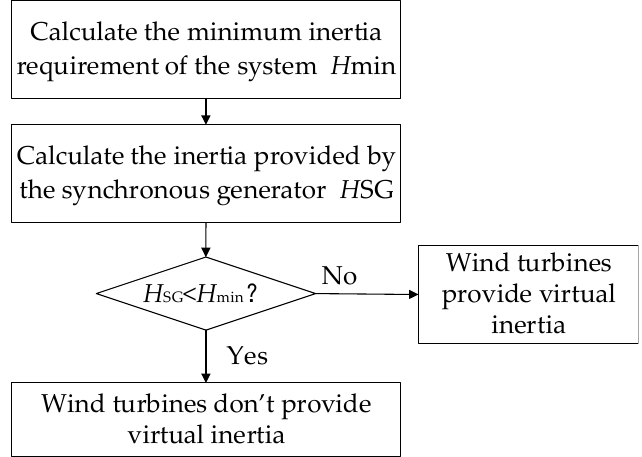
Figure 2. Decision of whether the wind turbines participate in the inertia response.